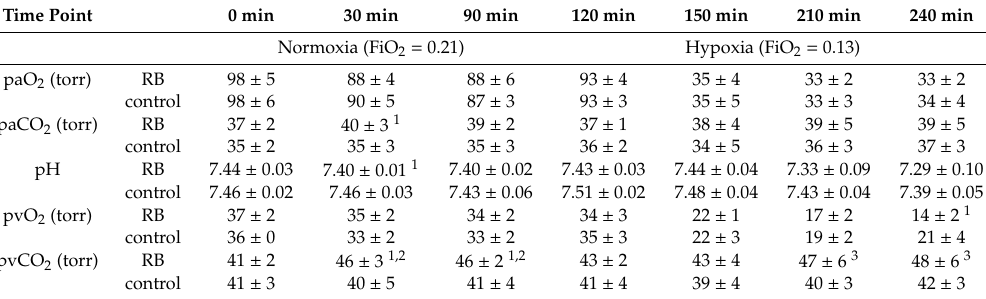
Table 2. Blood gas measurements ( n =